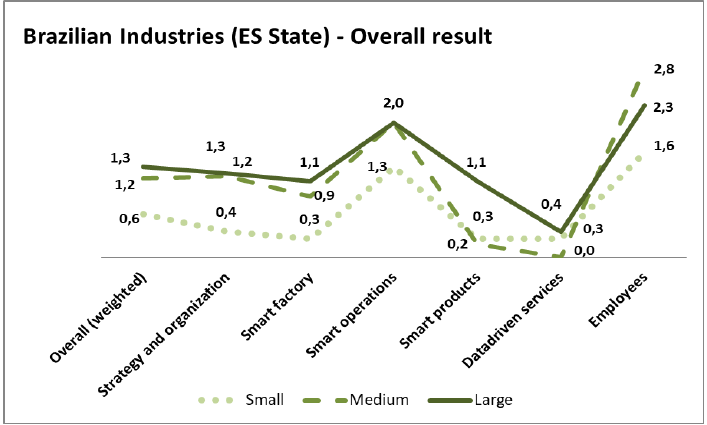
Figure 4. Overall result of Industry 4.0 maturity evaluation of Brazilian companies by companies’